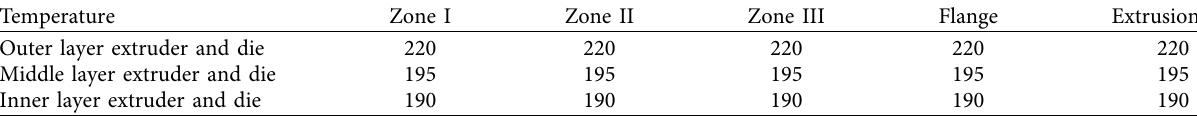
Table 1: Temperature control during extrusion experiments ( °